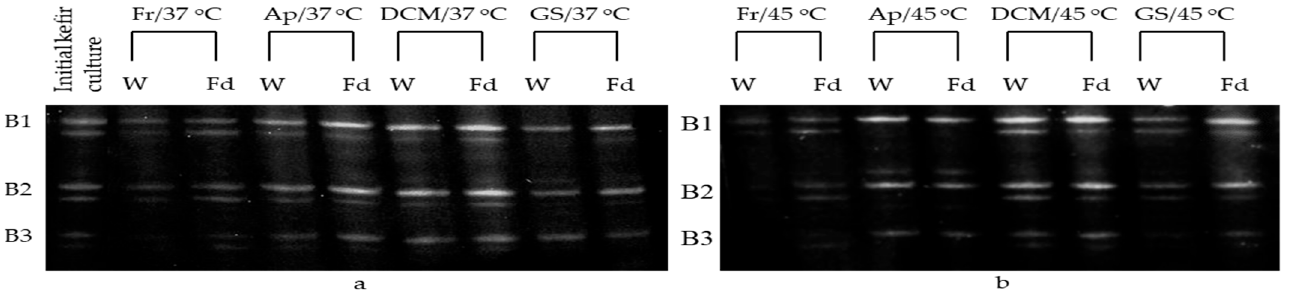
Figure 1. DGGE bacterial ( a , b ) and eukaryotic ( c , d ) fingerprint representing PCR-amplified 16S rRNA and 26S rRNA, respectively, from total community DNA derived from wet or freeze-dried free or immobilized kefir culture after semi- dry and sweet low alcohol wine-making at high temperatures (37 and 45 °C). For each sample, two replicate profiles from two independent nucleic acid extracts were analyzed and compared to free kefir culture (prior to use in fermentations). Fr: Free kefir culture, Ap: Immobilized kefir culture on apple pieces, DCM: Ι mmobilized kefir culture on DCM, GS: Ι mmo- bilized kefir culture on grape skins. W: Wet, Fd: Freeze-dried. The fermentation temperature is shown after the sample codes. Y1 band: Kluyveromyces marxianus / Kluyveromyces lactis, Y2 band: Saccharomyces cerevisiae , B1 band: Lactobacillus hel- veticus / Lactobacillus dextrinicus , B2/B3 band: Lactobacillus buchneri / Lactobacillus kefiri / Lactobacillus sunkii . 3.3. Volatiles 3.3.1. Major Volatiles Μ ajor volatile by-products detected are presented in Table 3. Ε thyl acetate, acetalde- hyde, and methanol concentrations were significantly ( p < 0.05) affected by the fermenta- tion temperature, while 1-hexanol and methanol content was significantly ( p < 0.05) af- fected by the nature of the cells. Strong interactions ( p < 0.05) were, however, noted in all cases. On the contrary, amyl and isoamyl alcohol and isobutanol content was significantly ( p < 0.05) affected by both the state of the cells and the fermentation